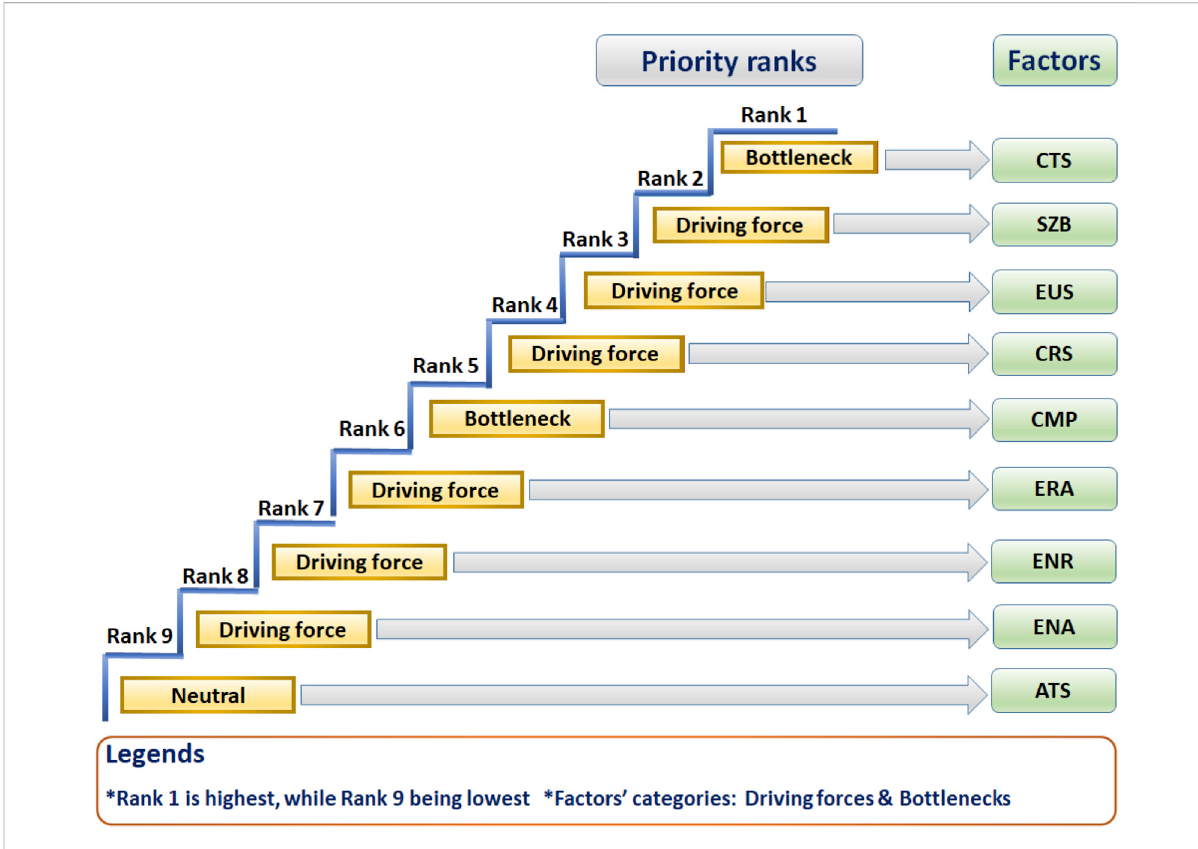
FIGURE 2 Importance ranking of factors in fl uencing the acceptance of SPS by